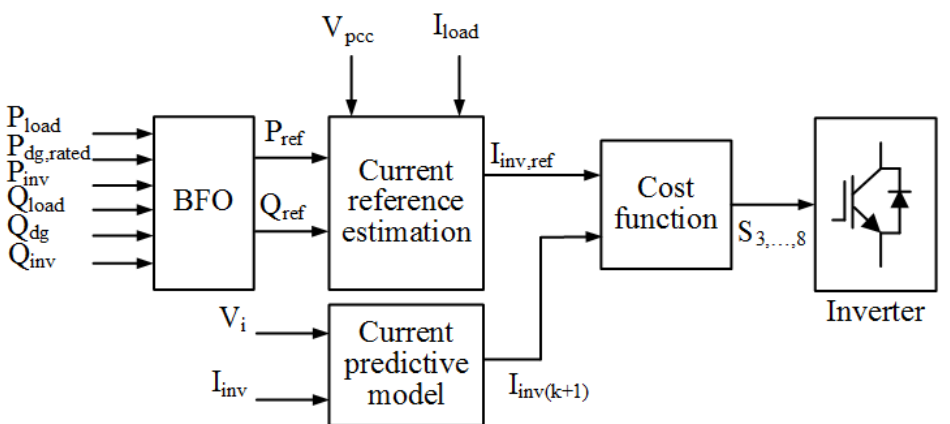
Figure 2. Block diagram of the bacterial foraging optimization (BFO) and predictive control.